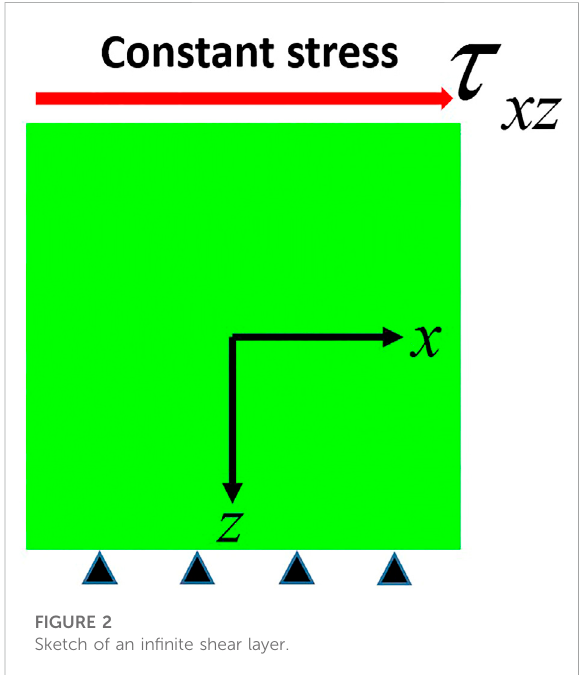
FIGURE 2 Sketch of an in fi nite shear